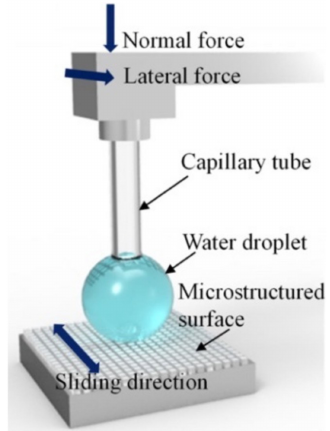
Figure 28. Schematic illustration of the use of a nanotribometer with a capillary tube to measure the sliding friction force between a drop and a surface (Reprinted with permission from [198]. Copyright {2017} American Chemical